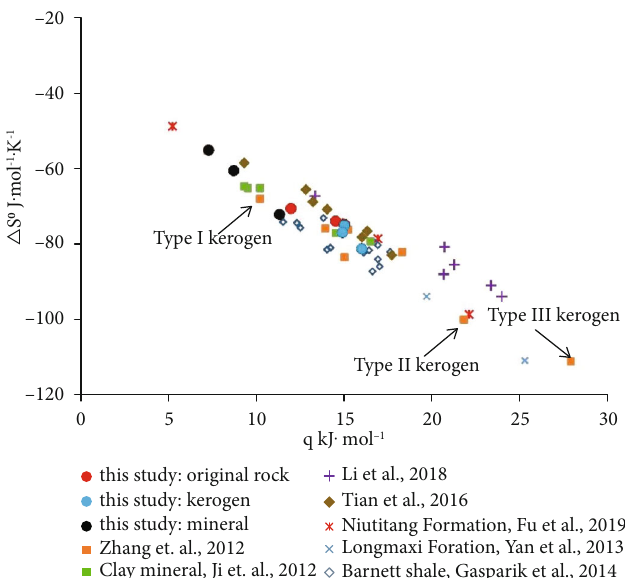
Figure 4: The thermodynamic parameters obtained in di ff erent adsorbents.